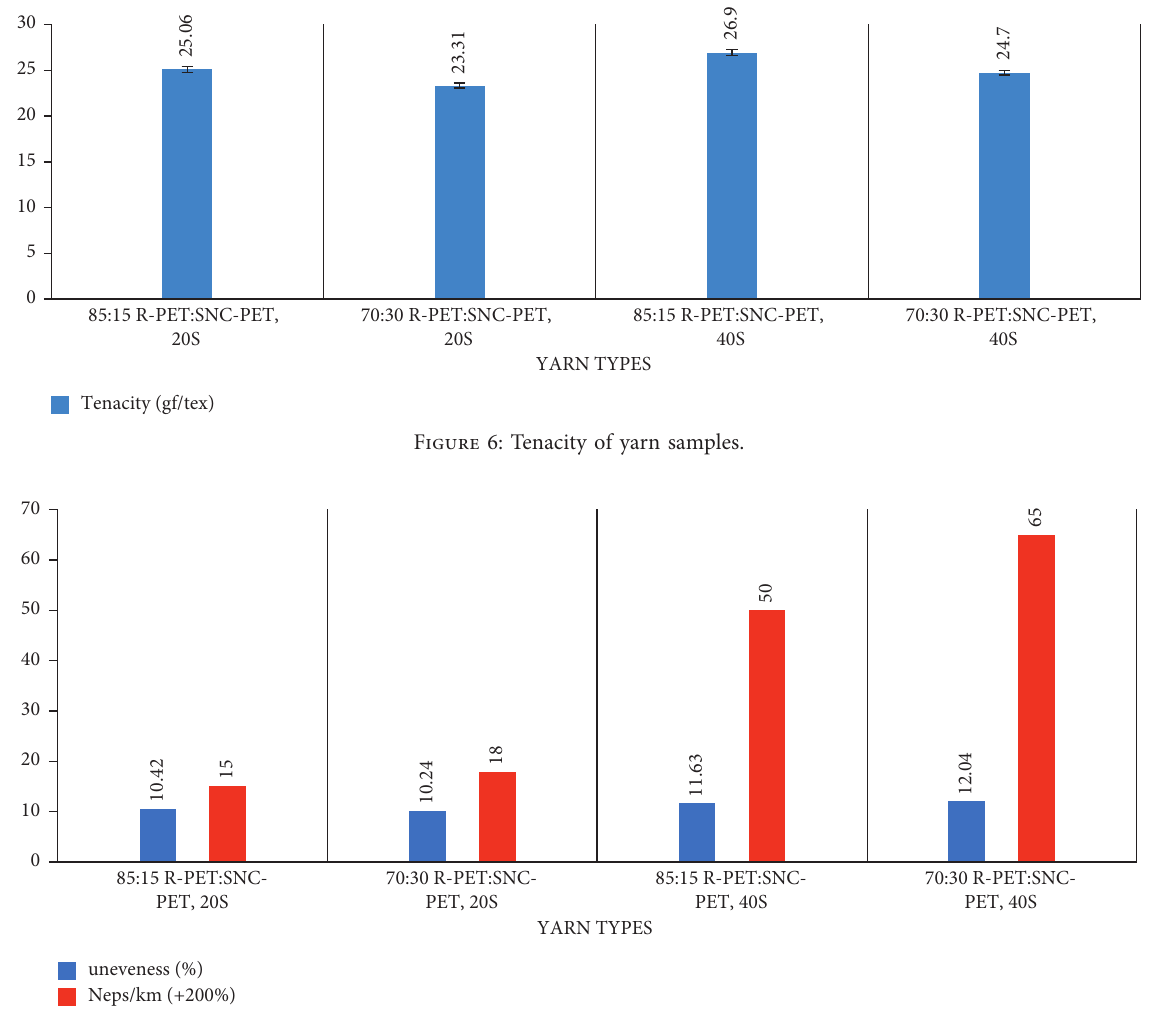
Figure 6: Tenacity of yarn samples.